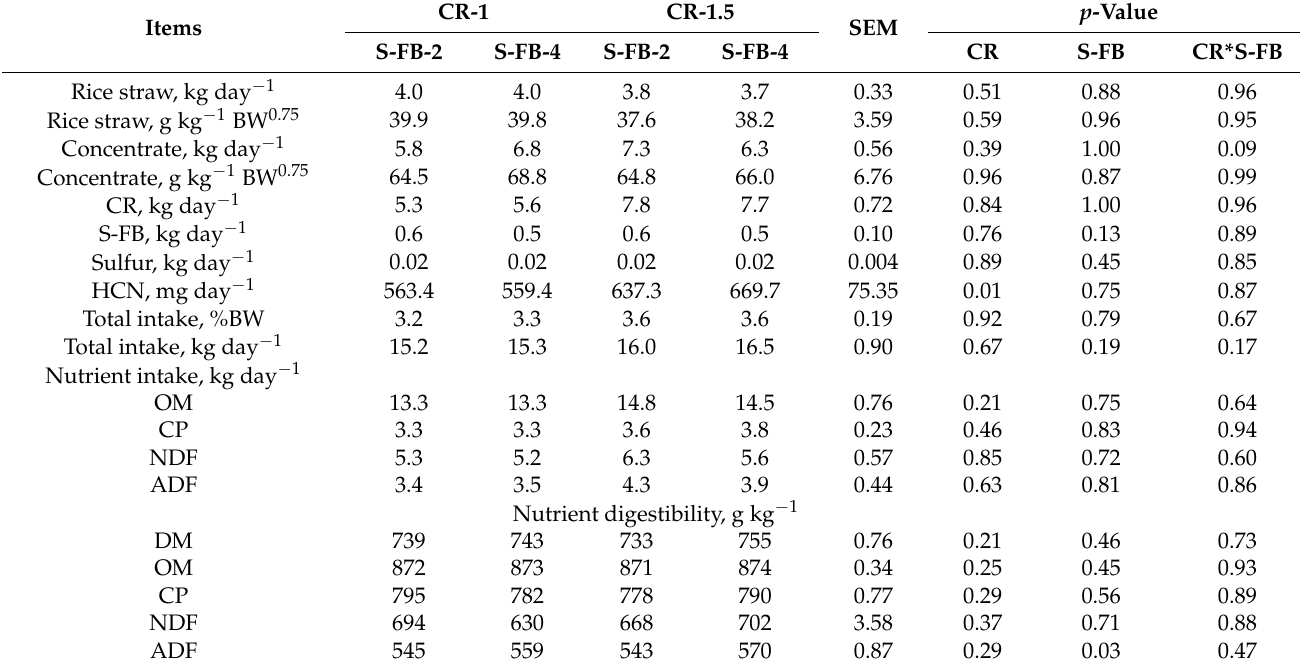
Table 2. Effect of cassava root (CR) and solid feed-block containing high sulfur (S-FB) on feed intake, nutrient intake, and nutrient digestibility in lactating dairy